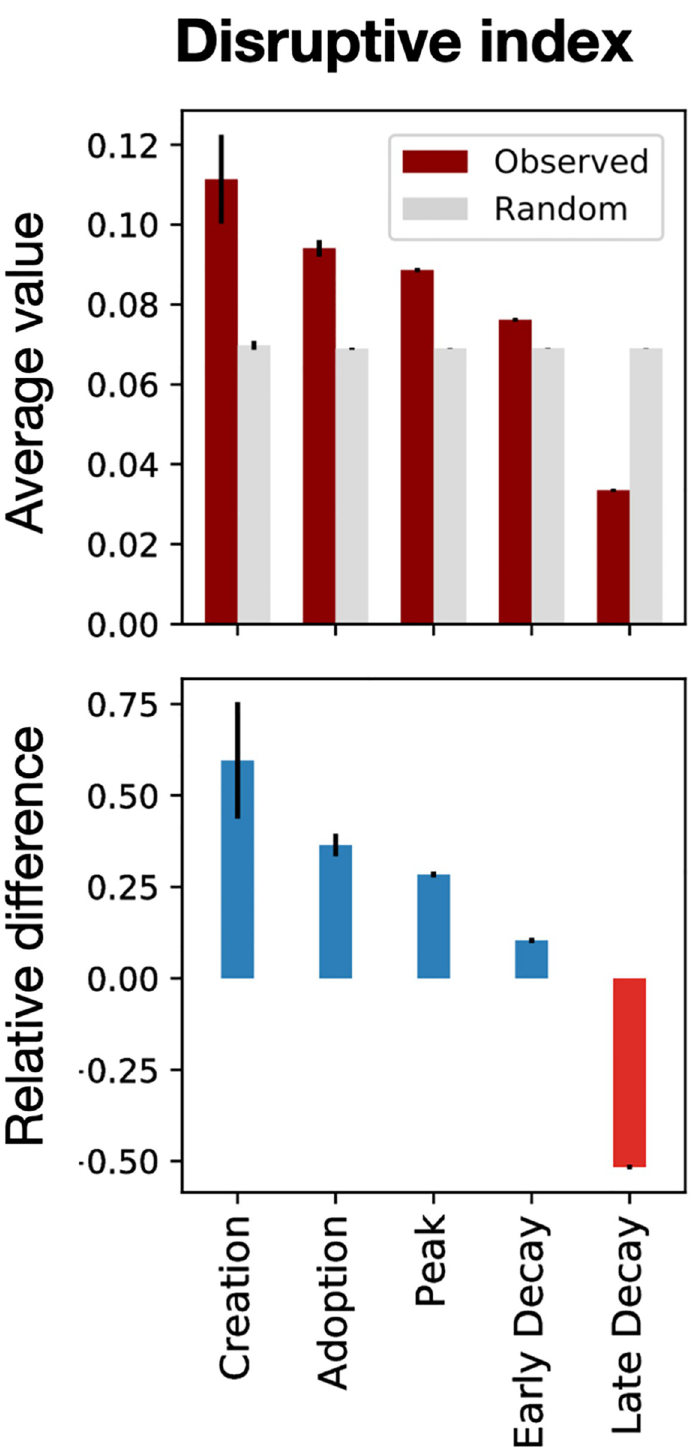
Fig 4. Disruptive index. Disruptive index measure for the articles in arXiv. The observed values are averaged over all articles (red bars). Gray bars correspond to the average random expectation (see Methods). Bottom plots represent the relative difference between observed and random values. Error bars denote standard errors for observed values (red) and standard deviation for random values (gray). Earlier stages of fields evolution have more disruptive articles with a steady decrease in later